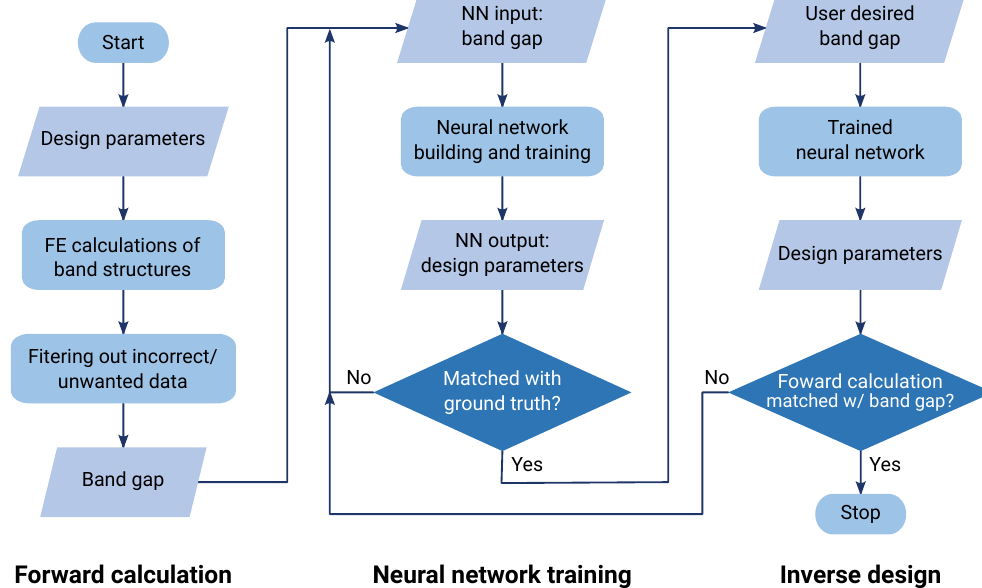
Figure 3. The proposed framework for the metamaterial design in this